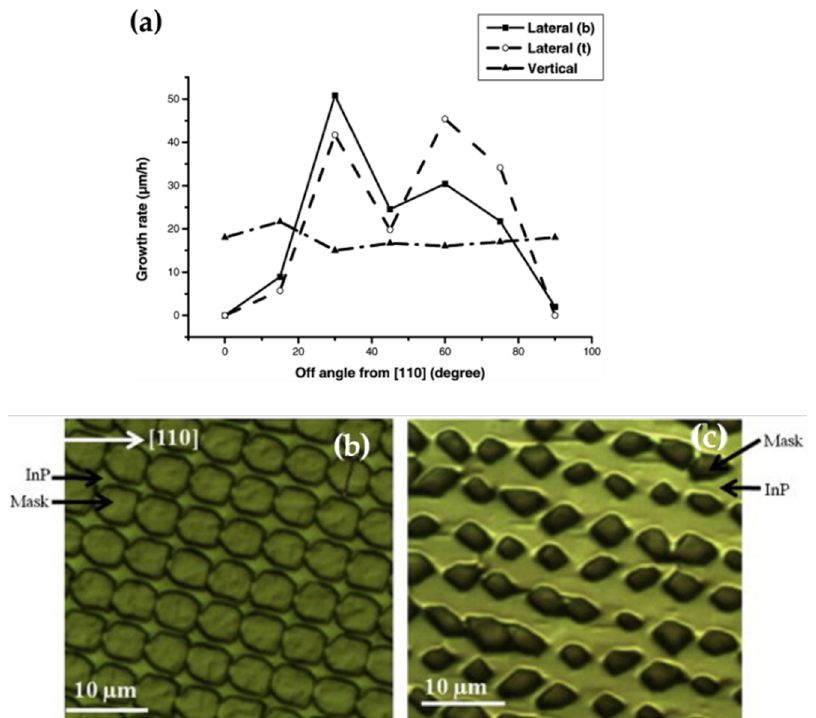
Figure 13. ( a ) Dependence of the growth rates on the off angle from [110] direction. Nomarski contrast images of sample after ( b ) 0.5 min and ( c ) 1.5 min growth with mesh opening mask tilted 15° off [110]’s direction. (a): Reprinted with permission from Reference [197] © 2001 Elsevier Science B.V. (b) and (c): Reproduced with permission from Reference [199] © 2011 Elsevier B.V.